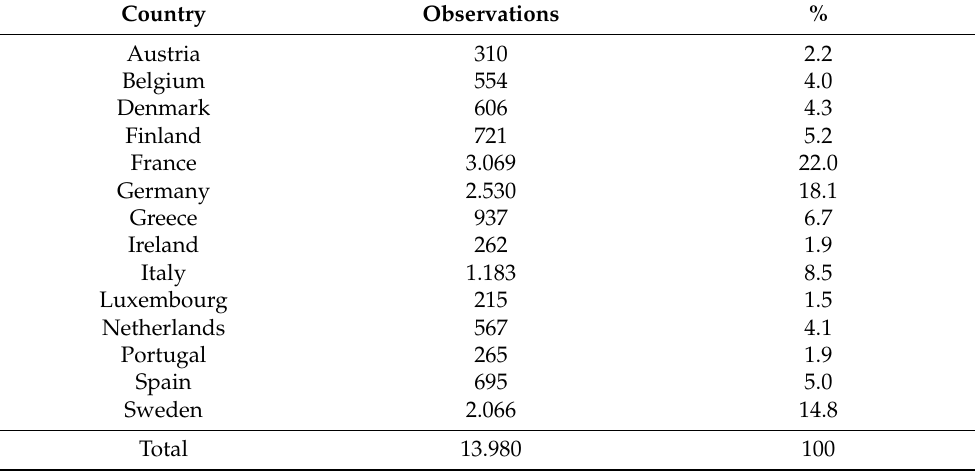
Table 1. Sample composition by